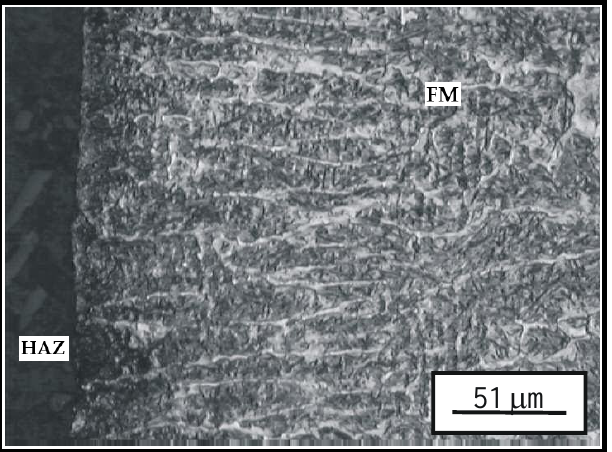
Figure 8. Microstructure of the hard-faced layer executed by the FM Castolin 2.